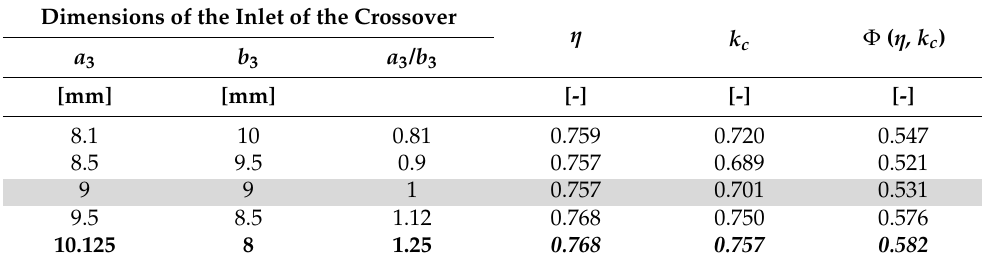
Table 9. The effect of the dimensions of the inlet cross-section of the crossover.